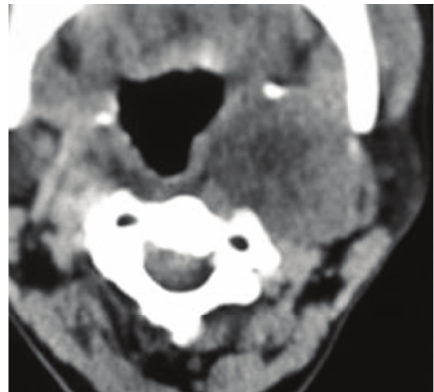
Figure 2: Computed tomography of the neck shows a heteroge- neously enhancing hypodense mass on the left carotid space causing splaying of carotid bifurcation.